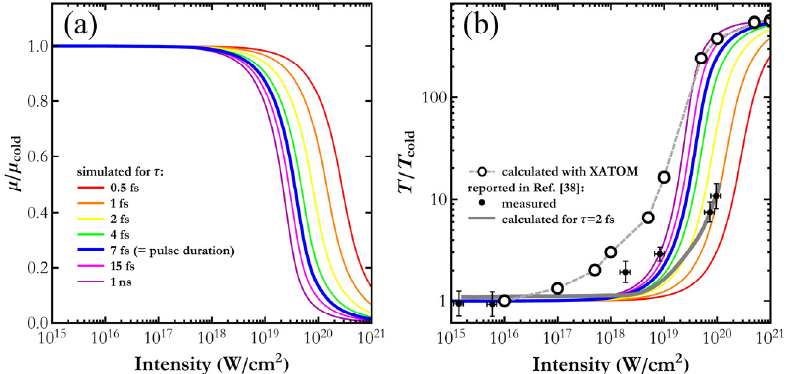
Figure 4. The influence of saturable absorption on linear attenuation coefficient ( a ) and transmission ( b ). ( b ) contains additional data taken from Ref. [38] measured and calculated for incidence X-ray pulse length of 7 fs as well as another dataset obtained with the XATOM code [50].